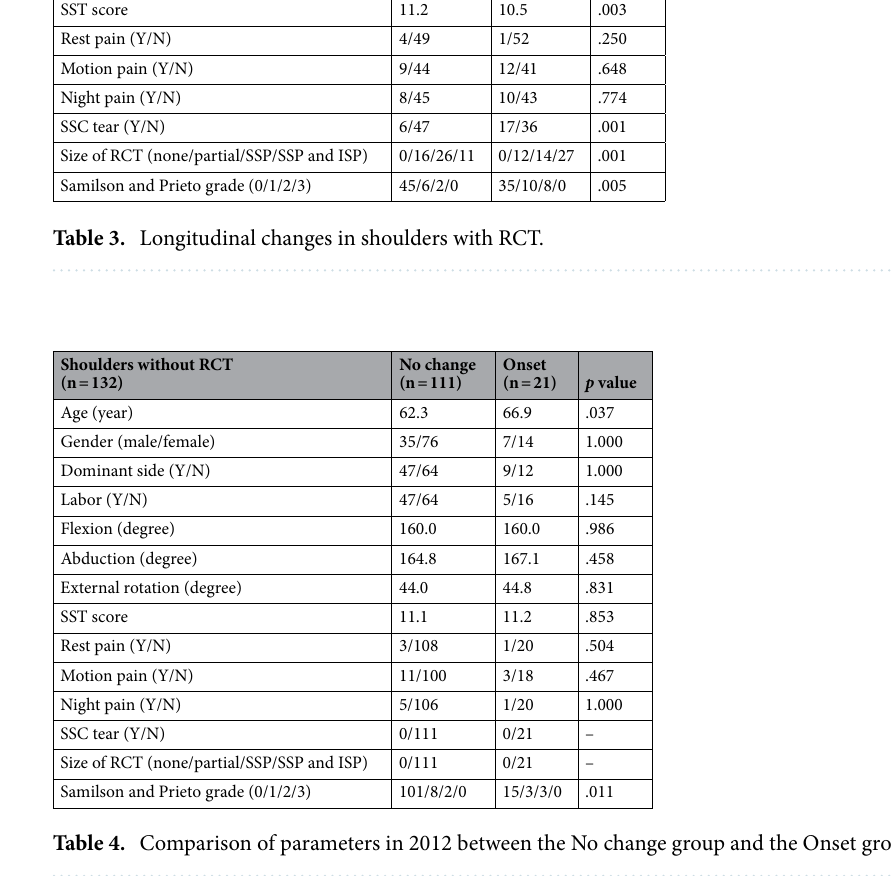
Table 4. Comparison of parameters in 2012 between the No change group and the Onset group.